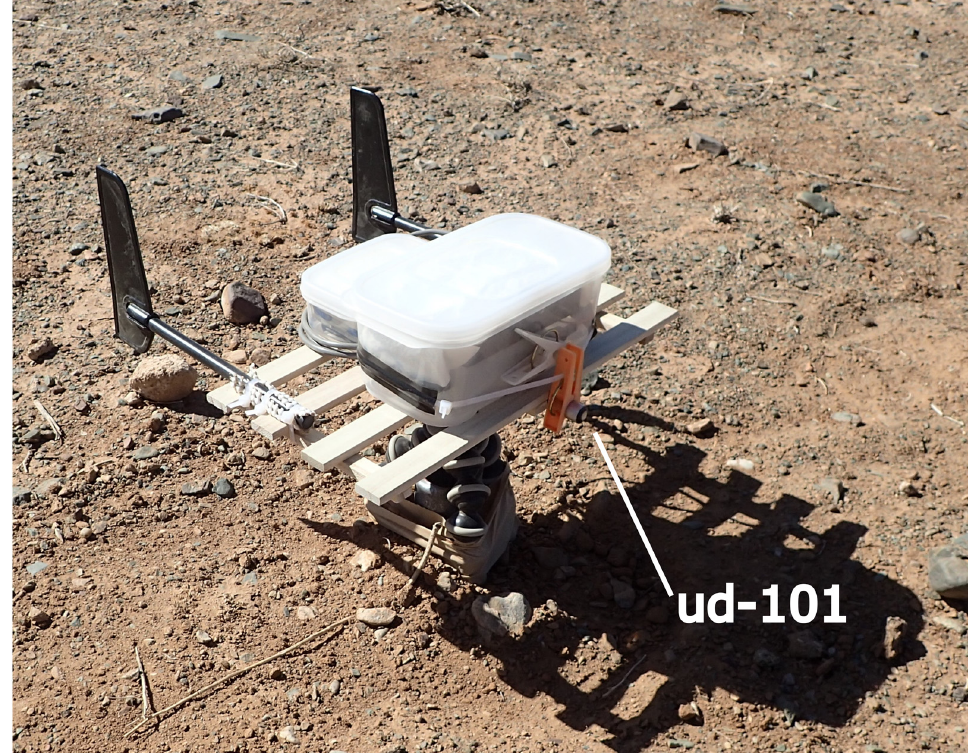
Figure 3. Image of a piezoelectric particle counter (ud-101) on a platform equipped with wind vanes. The instrument rotated depending on the wind direction so that it always faced upwind.